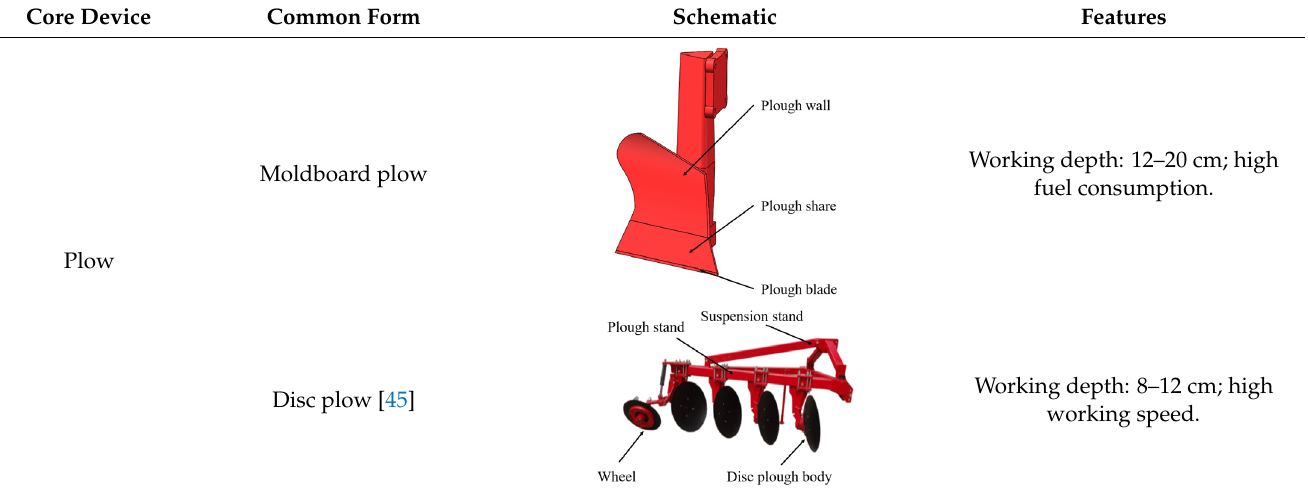
Table 7. Common types of plow.